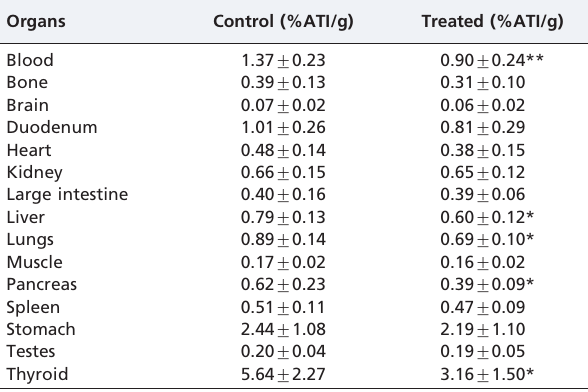
Table II - The effect of the senna extract on the biodistribution of Na 99m TcO 4 in Wistar rats. Organs Control (%ATI/g) Treated